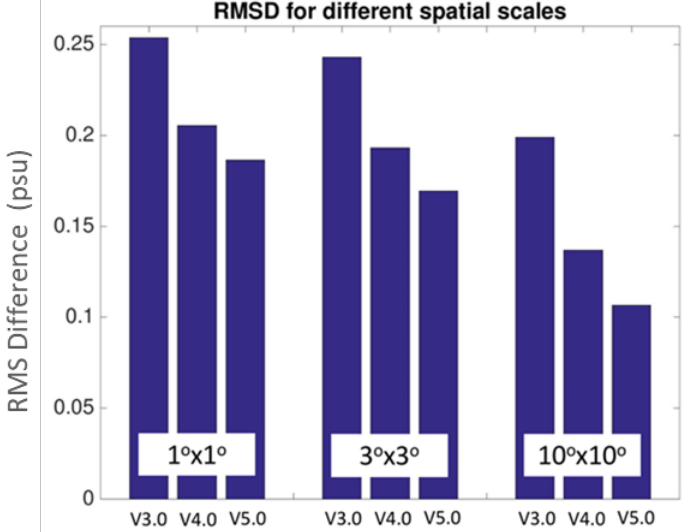
Figure 4. Global average of regional temporal root mean square difference (RMSD) between Aquarius Level 3 monthly SSS and monthly Argo gridded maps as a function of the spatial scale for the entire mission. The three bars represent Version 3, 4, and 5 retrievals. The Argo data used in the comparison are from the gridded product from the Scripps Institute of Oceanography: http://apdrc.soest.ucsd.edu/ Gridded_fields.html. The data are from Section 10 of Kao et al. [22], which also contains more